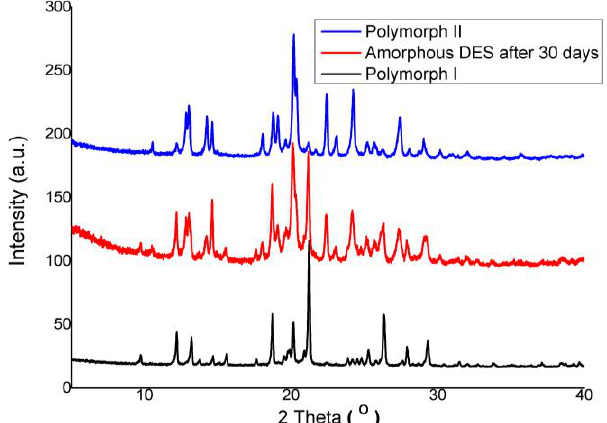
Figure 8. PXRD patterns of pure crystalline desloratadine (polymorph I) (black line), pure amorphous desloratadine after 30 days (red line) and pure crystalline desloratadine (polymorph II) (blue line).